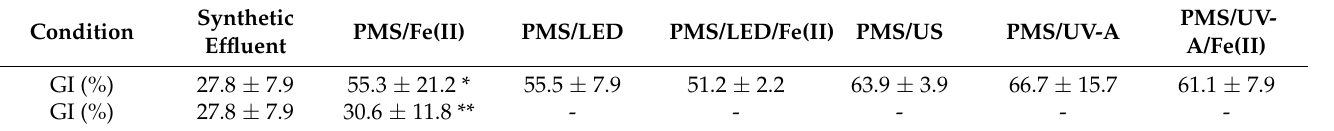
Table 5. Germination index (GI) results for L. sativum for different